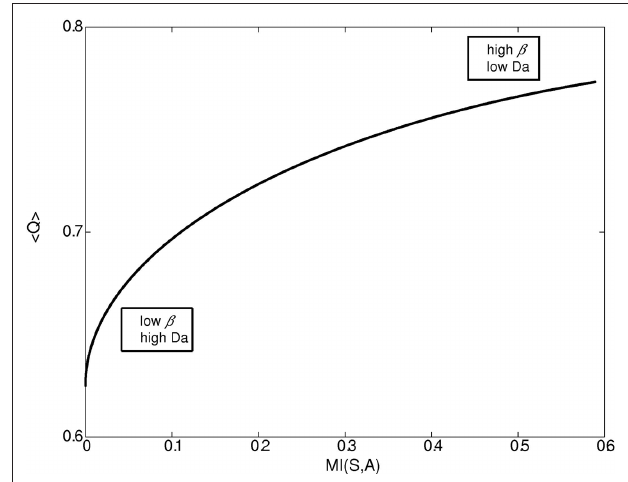
FigurE 1 | Expected reward as a function of the complexity of the behavioral policy for different β /dopamine levels. High dopamine (Da) or low β (inverse of the softmax pseudo-temperature variable) lead to a simple reward policy, e.g., a random policy with low state–action mutual information (MI( s,a )), and low expected reward <Q>. On the other hand, a low dopamine level leads to a complex (deterministic) policy with high MI and high expected reward. In general, both state–action MI and expected reward <Q> increase with beta (though when beta is close to 0, the increase in MI is